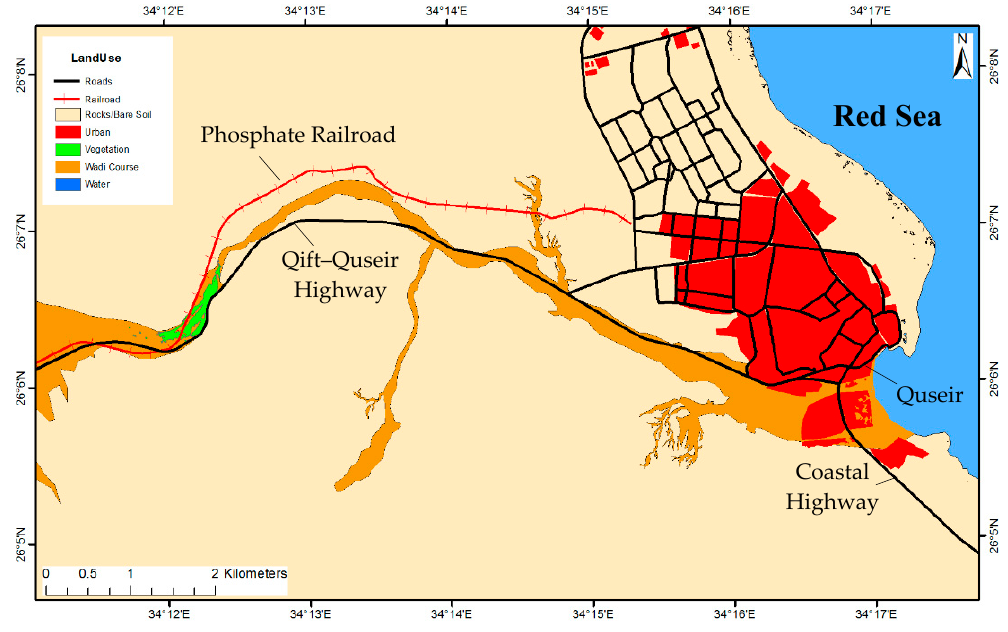
Figure 5. WV-2 derived land use land cover (LULC) for the downstream area of Wadi El-Ambagi.